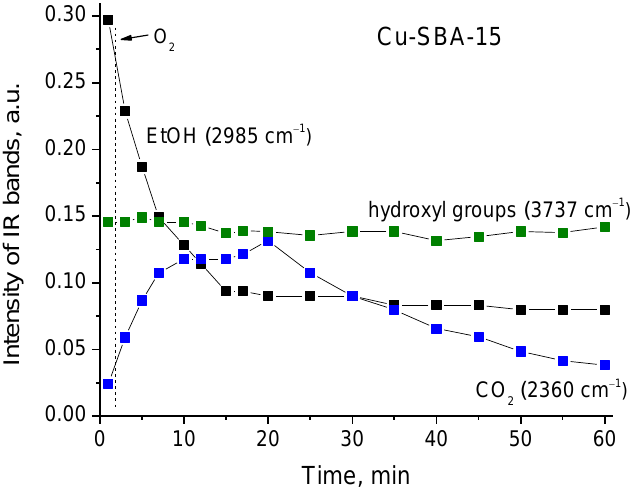
Figure 12. Changes in the intensity of the IR bands in the spectra recorded after pretreatment of Cu-SBA-15 catalyst with ethanol at 473 K for 45 min and oxygen flow included for the following 60 min: EtOH (black), CO 2 (blue), and consumption of hydroxyl groups (green).